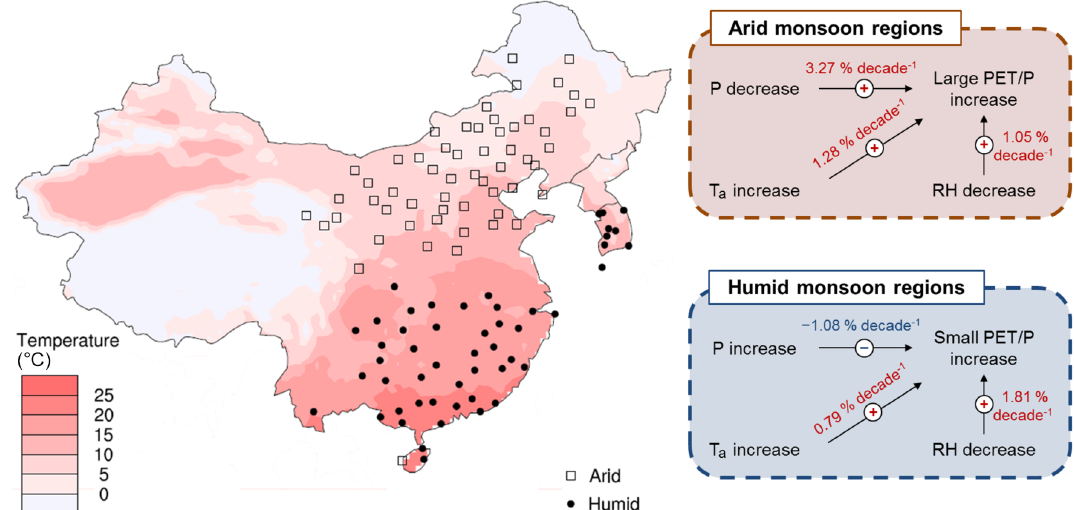
Figure 8. Schematic diagram of the contributions of P , T a , and RH on the PET /P trends in arid and humid monsoon regions for the period of 1983–2010. Diagrams of the influences of P , T a , and RH on the trend in PET /P over arid and humid monsoon regions in 1983–2010 are located to the right of the annual mean temperature over continental eastern Asia for 1961–2010 ( ◦ C). The open squares and filled circles are stations classified as arid and humid monsoon regions (east of 100 ◦ E),